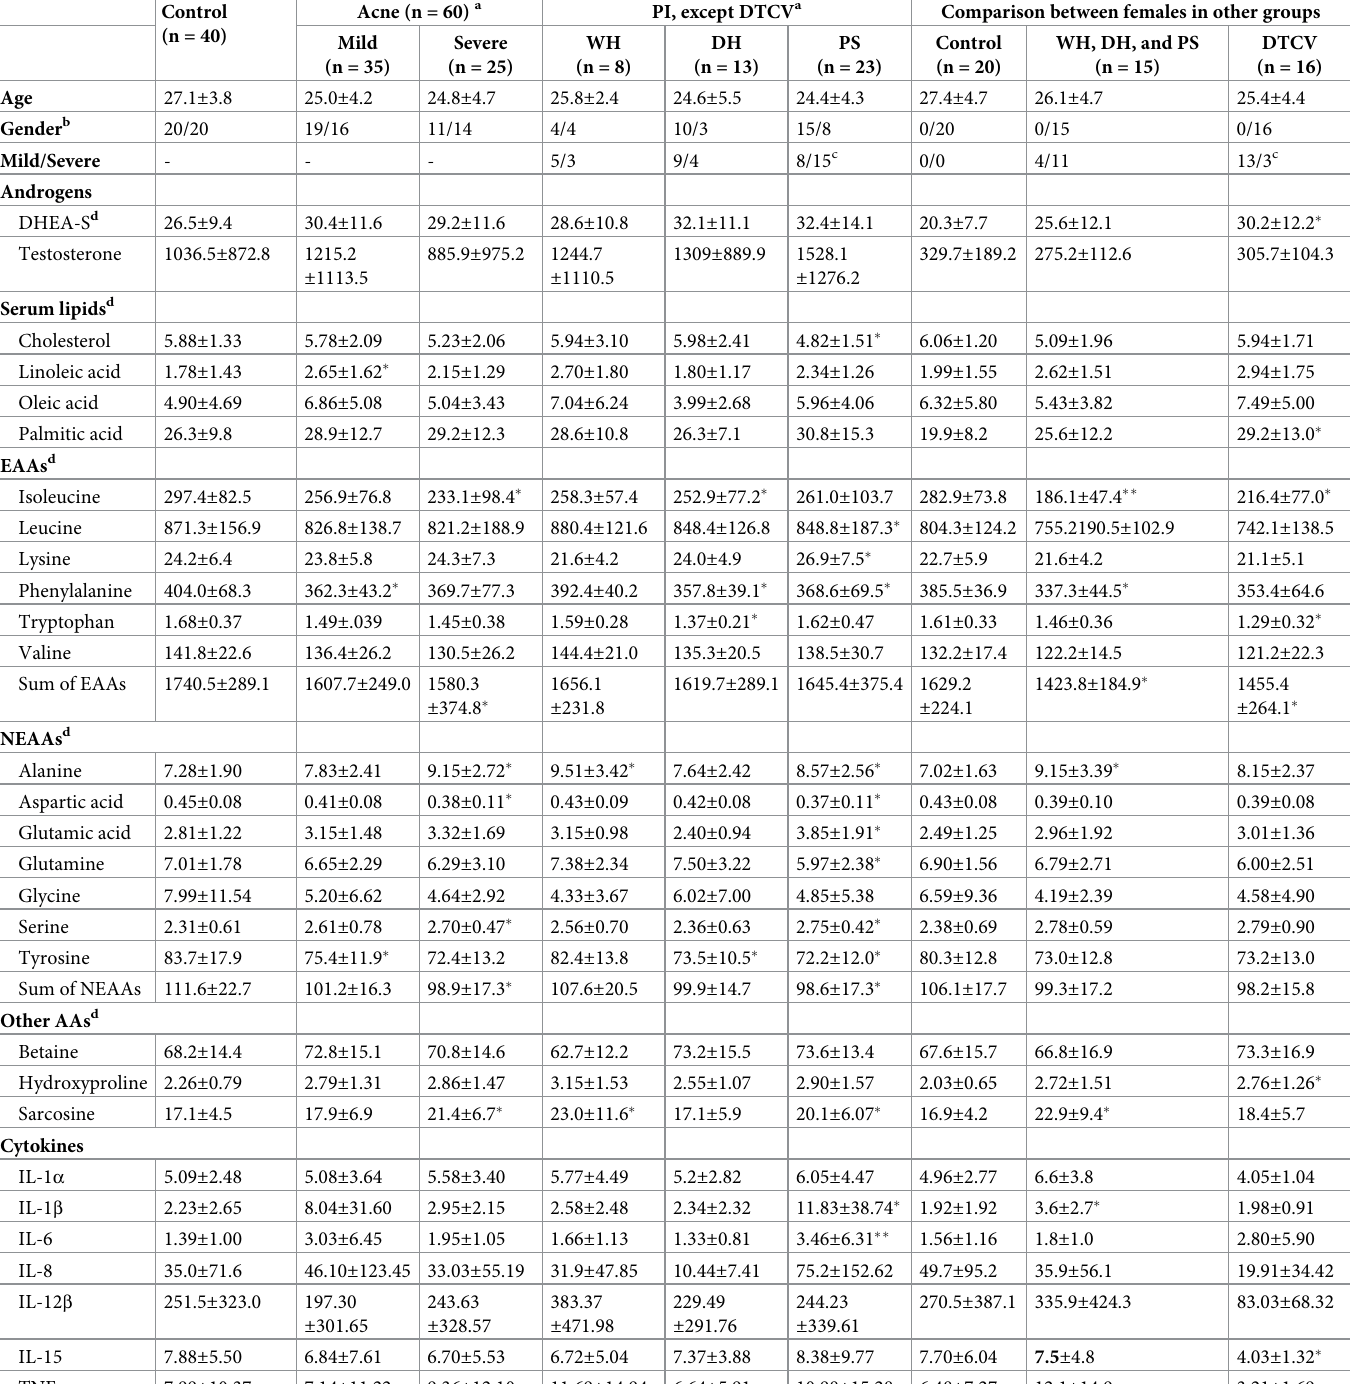
Table 5. Comparison of metabolomic profiles with pro-inflammatory cytokines according to disease severity and